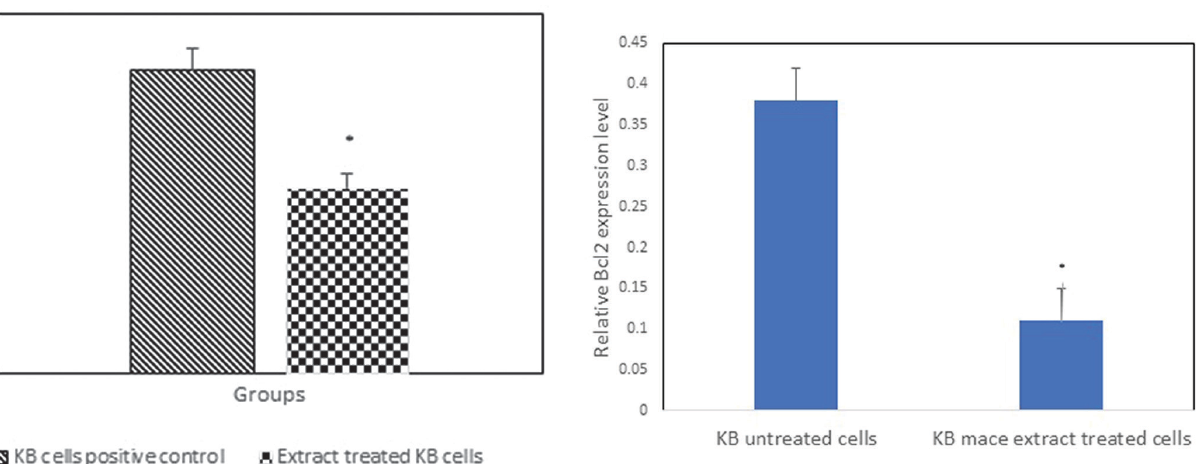
FIGURE 6 - Effect of mace extract treatment on BCl expression in KB cells. Lane 1 - 1 1KB DNA Ladder; Lane 2 - GAPDH expression in control KB cells; Lane 3 - GAPDH expression in mace extract treated KB cells; Lane 4 - BCl expression in control KB cells; Lane 5 - BCl in extract treated KB.